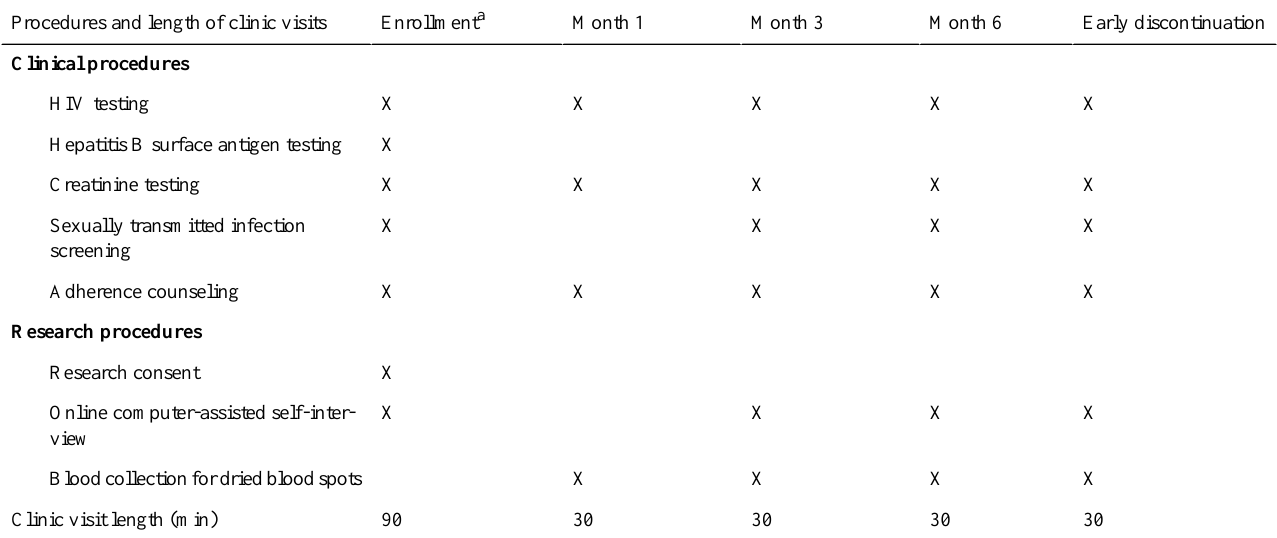
Table 2. Timing of procedures for the Hit Me Up!